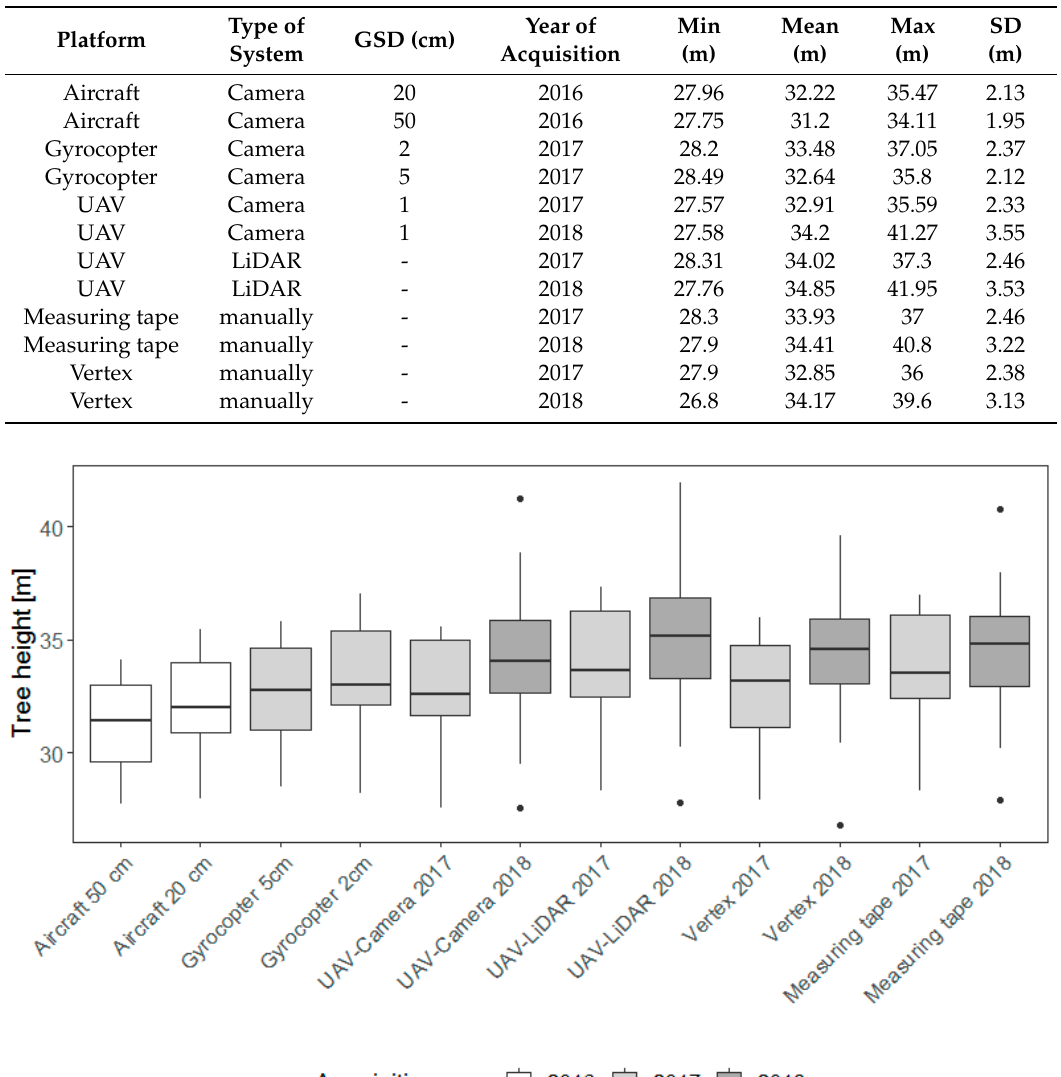
Table 2. Summary statistics of tree height (n = 15) by field measurements and remote sensing. Platform